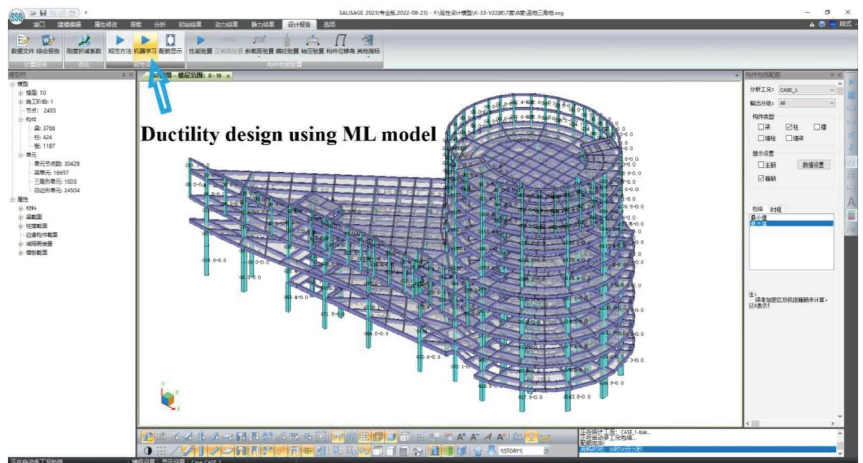
Figure 11: Ductility design using ML model in SAUSG software. Schematic diagram displayed for transverse reinforcement